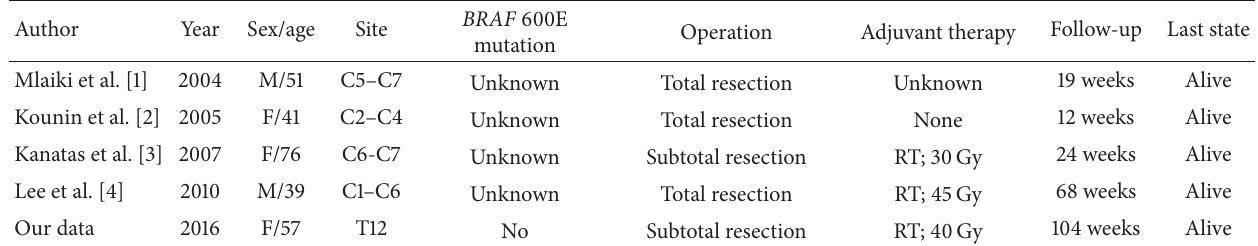
Table 1: Summary of primary intradural extramedullary spinal cord